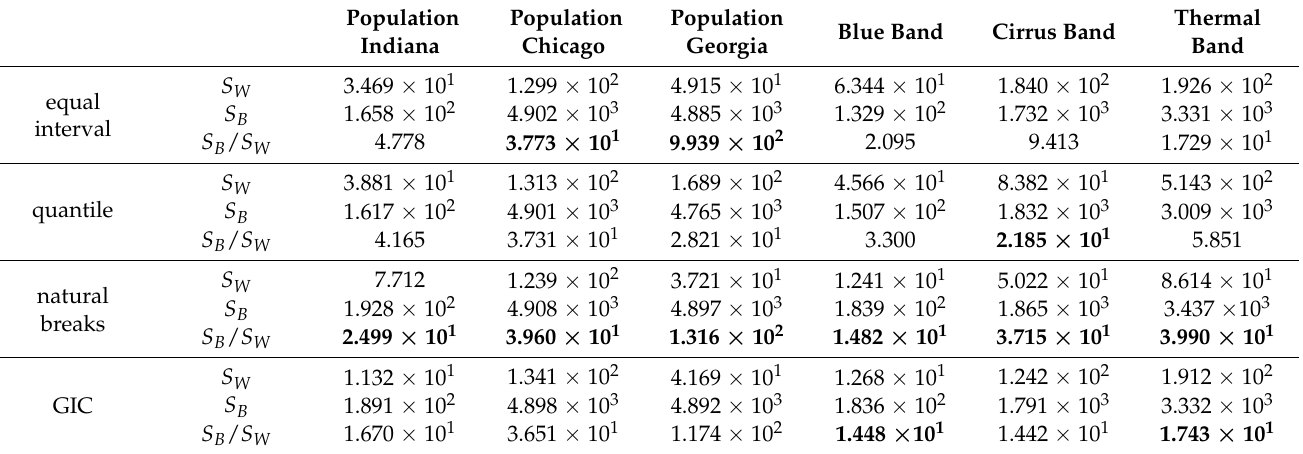
Table 6. Information entropy of the classification results from GIC and comparison methods.